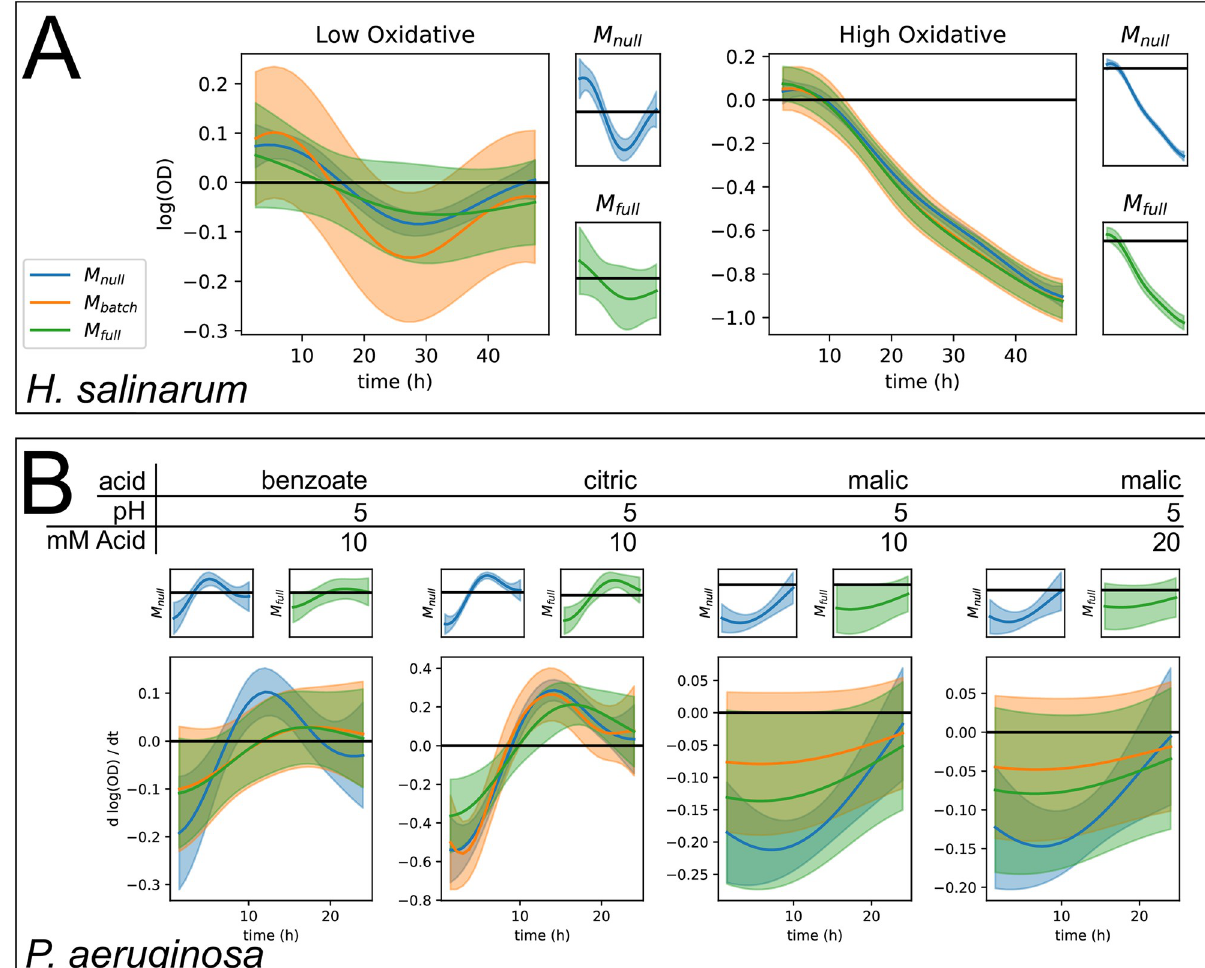
Fig 5. Hierarchical models of growth control for batch effects. Posterior intervals of functions estimated by models of increasing hierarchical complexity: M null (blue), M batch (orange), and M full (green). Solid line indicates posterior mean and shaded regions indicate 95% credible regions. We also plot M null and M full in separate axes to highlight the posterior intervals estimated by these models. (A) Posterior interval of δ ( t ) for low (left) and high (right) OS response by H. salinarum . (B) Posterior interval of interaction function ( αβ ) acid